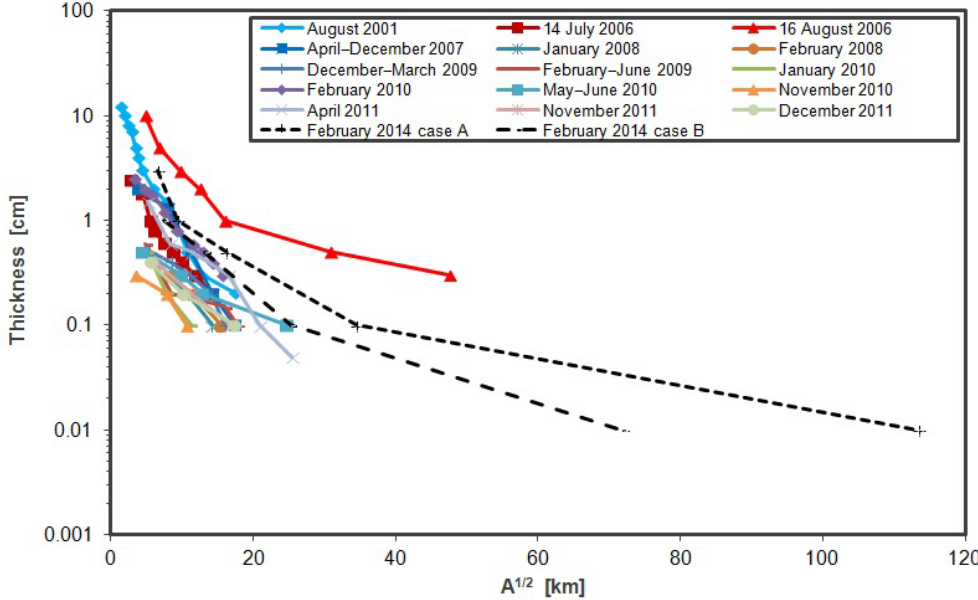
Figure 11. Plot of thickness (cm) vs. square root area (km) for tephra fall deposits from eruptions during the period 1999–2014 at Tungurahua volcano. Modified from Bustillos et al. (2016) and based on data from Jaya (2004), Troncoso et al. (2006), Bustillos (2010), Le Pennec et al. (2012), Bernard et al. (2013), and Bustillos et al.